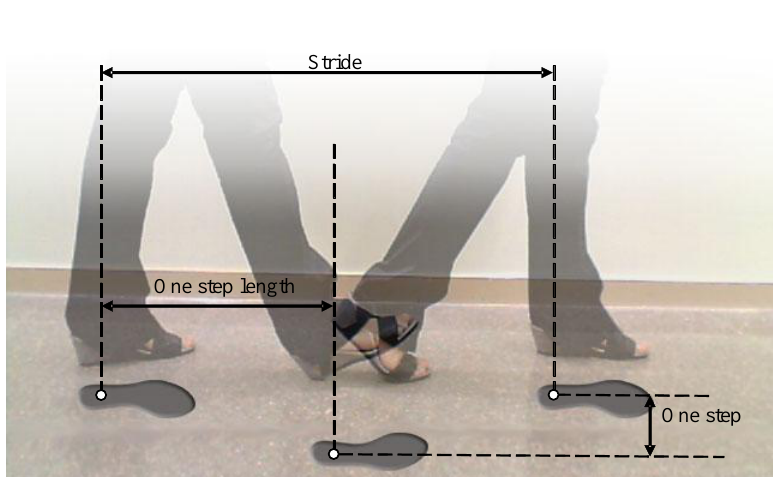
Figure 5. Gait parameters.